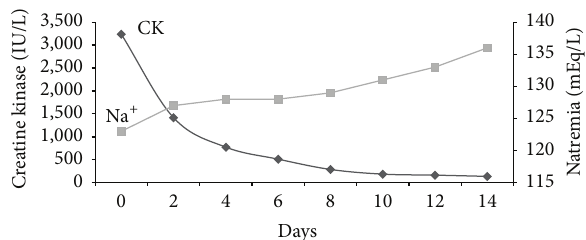
Figure 1: Decrease in creatine kinase and increase in natremia levels in the two-week period following inpatient